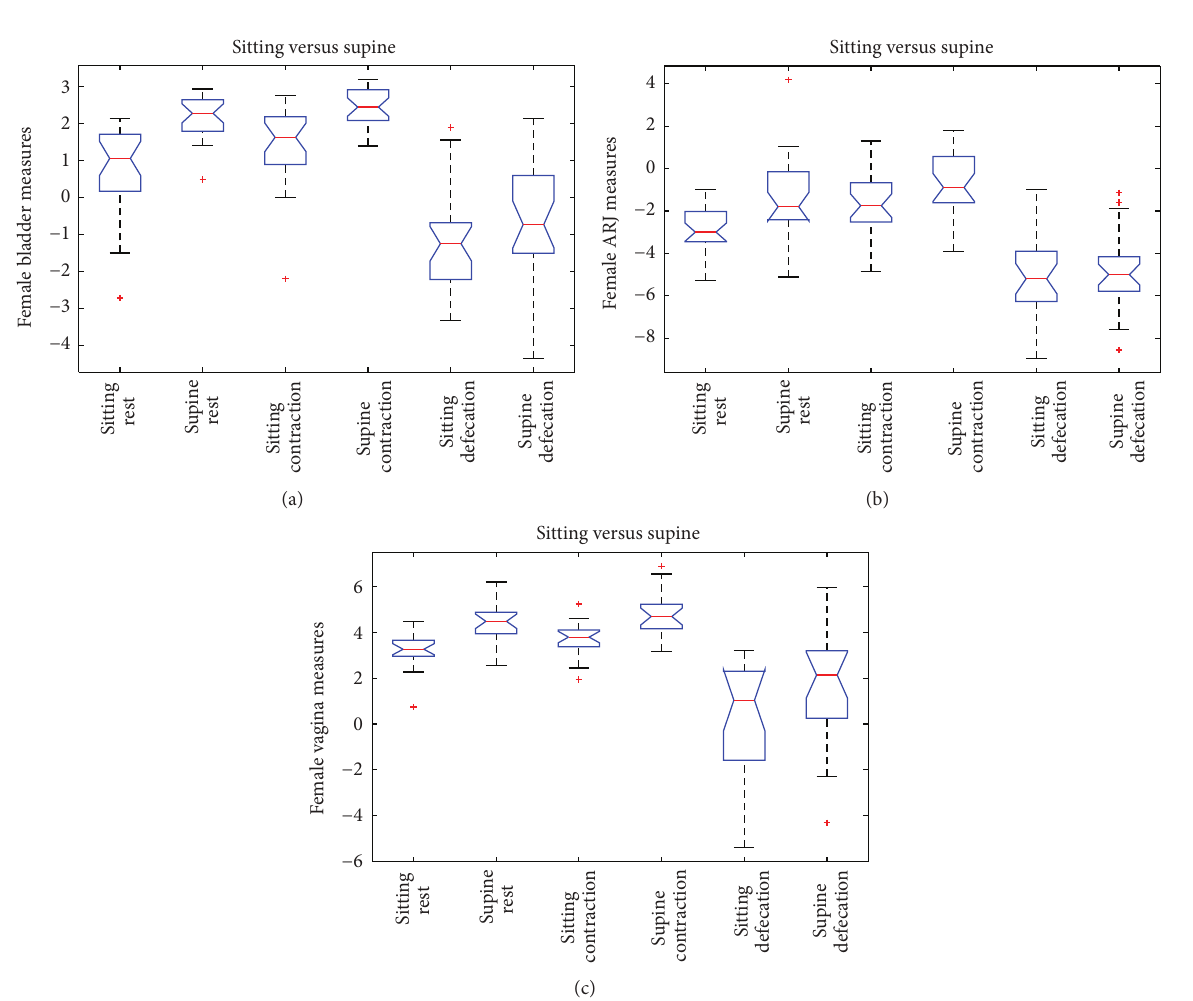
Figure 6: ANOVA box plot for bladder (a), vagina (b), and ARJ (c) measures of the female